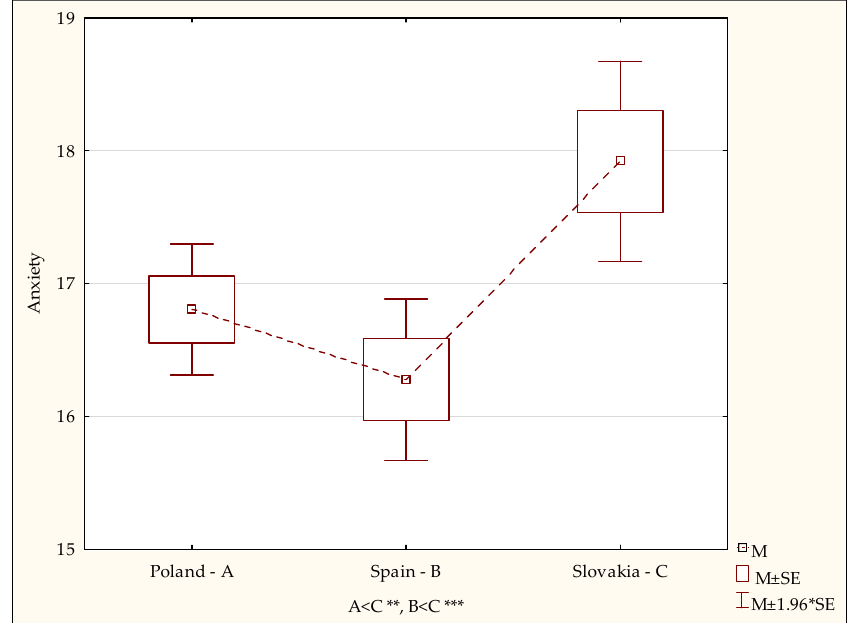
Figure 2. Diversity of scores in the anxiety control subscale in the Polish, Spanish and Slovak studies. Statistically significant: ** p < 0.01; *** p < 0.001